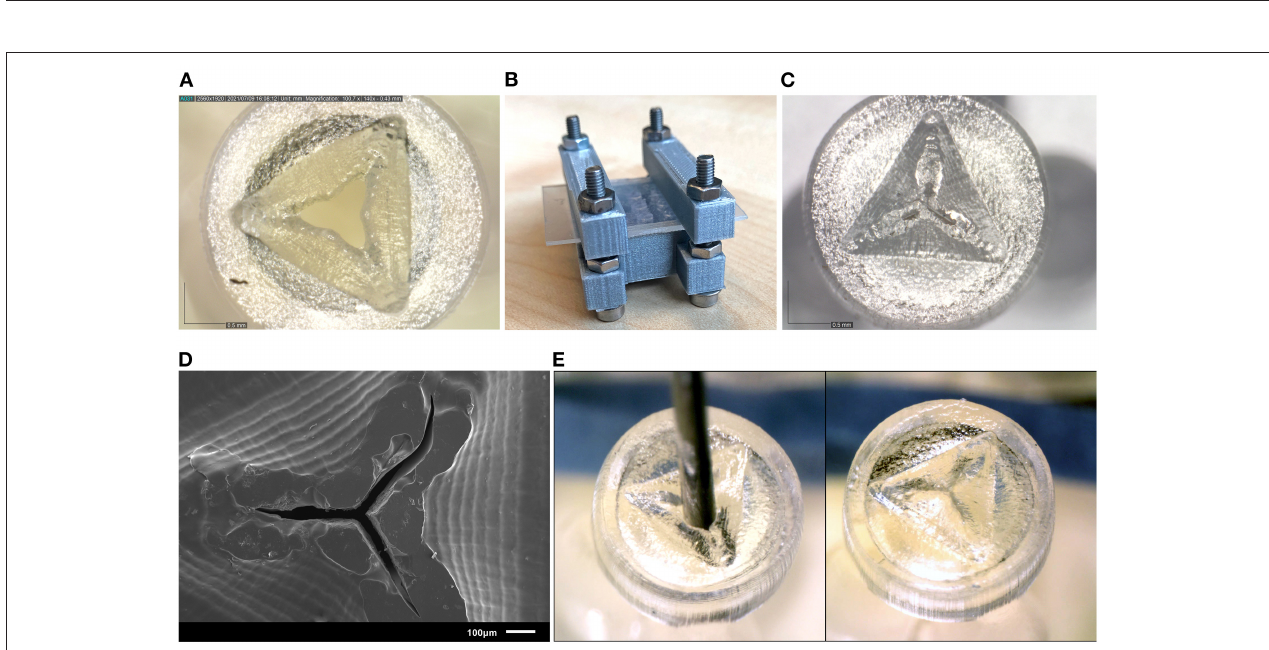
FIGURE 7 | Results of the new valve 3D print process. (A) Close up of a valve before curing, showing the opened valve flaps. (B) Clamp set up for curing the valves. (C) Close up of the valve after curing, the valve flaps have been pressed to their horizontal position, and no gap is visible between the flaps. (D) SEM image of the valve after curing. (E) Needle insertion test of the new valves, the needle can be easily inserted through the valve (left) and afterwards the flaps return to their horizontal position (right).